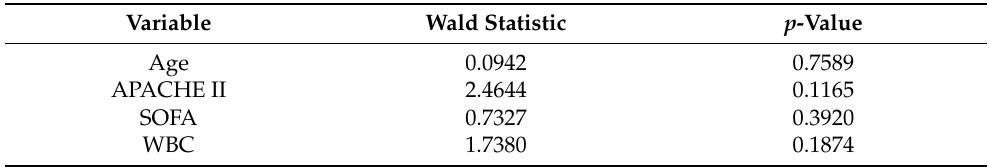
Table A6. The likelihood ratio test applied on the initial set of variables used in Cox proportional hazards